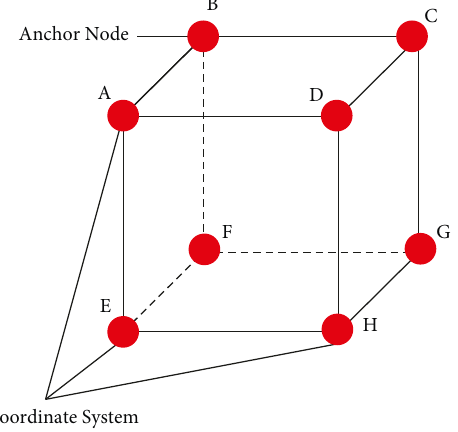
Figure 9: 3D Space of nanonetwork.